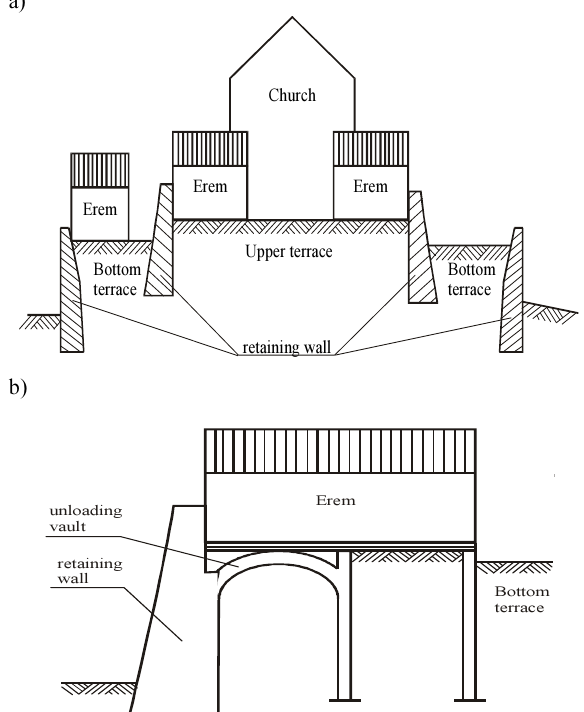
Fig. 7. Cross-sectional diagram of the Hill: a) section for terra- ces with massive retaining walls; b) unloading